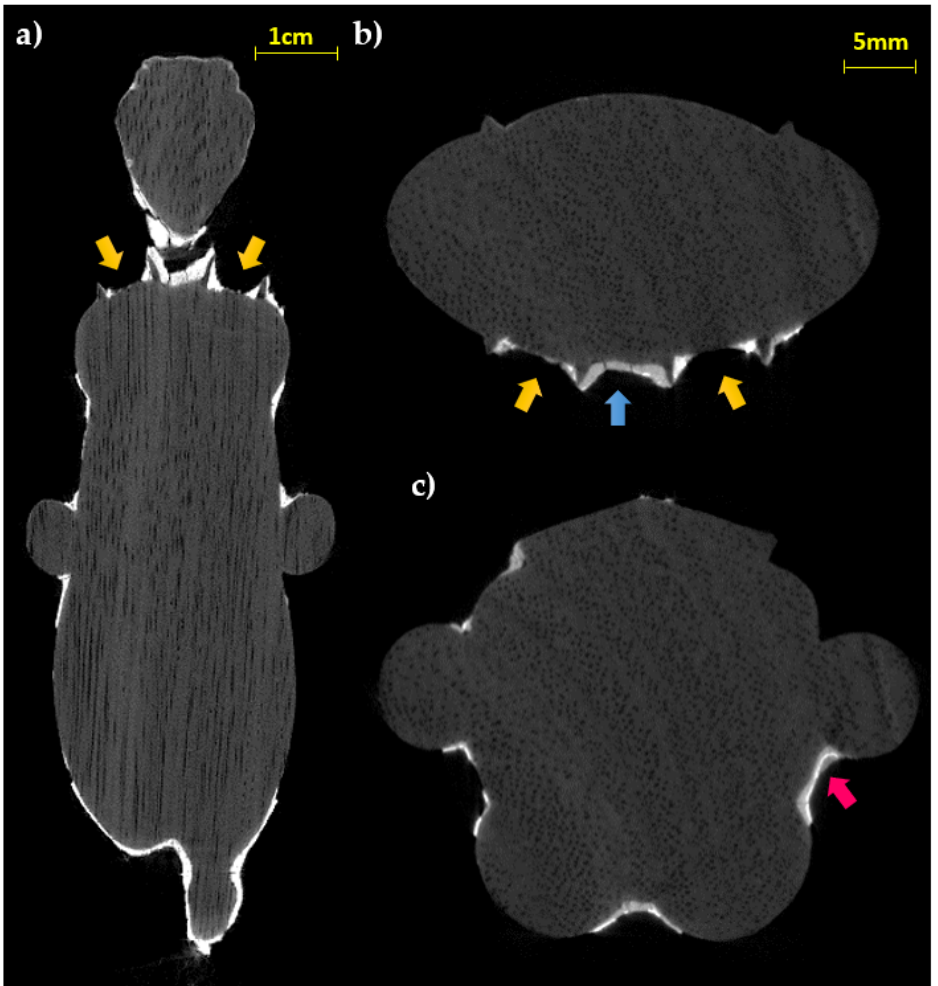
Figure 5. CT longitudinal ( a ) and horizontal ( b,c ) slices (yellow arrows: wing grooves; blue arrow: fractures inside the preparation layer; pink arrow: material layer above the gold leaf).